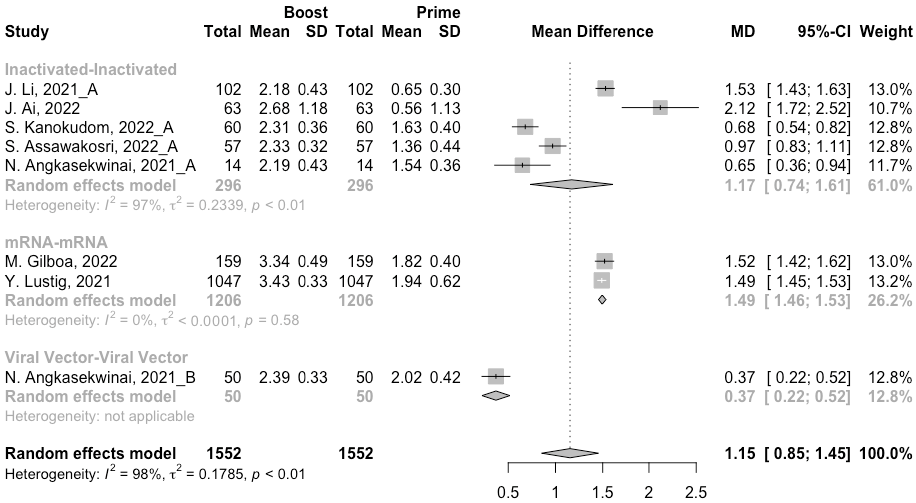
Figure 6. Forest plot of the pooled log-transformed anti-RBD IgG before and after homologous booster vaccination.